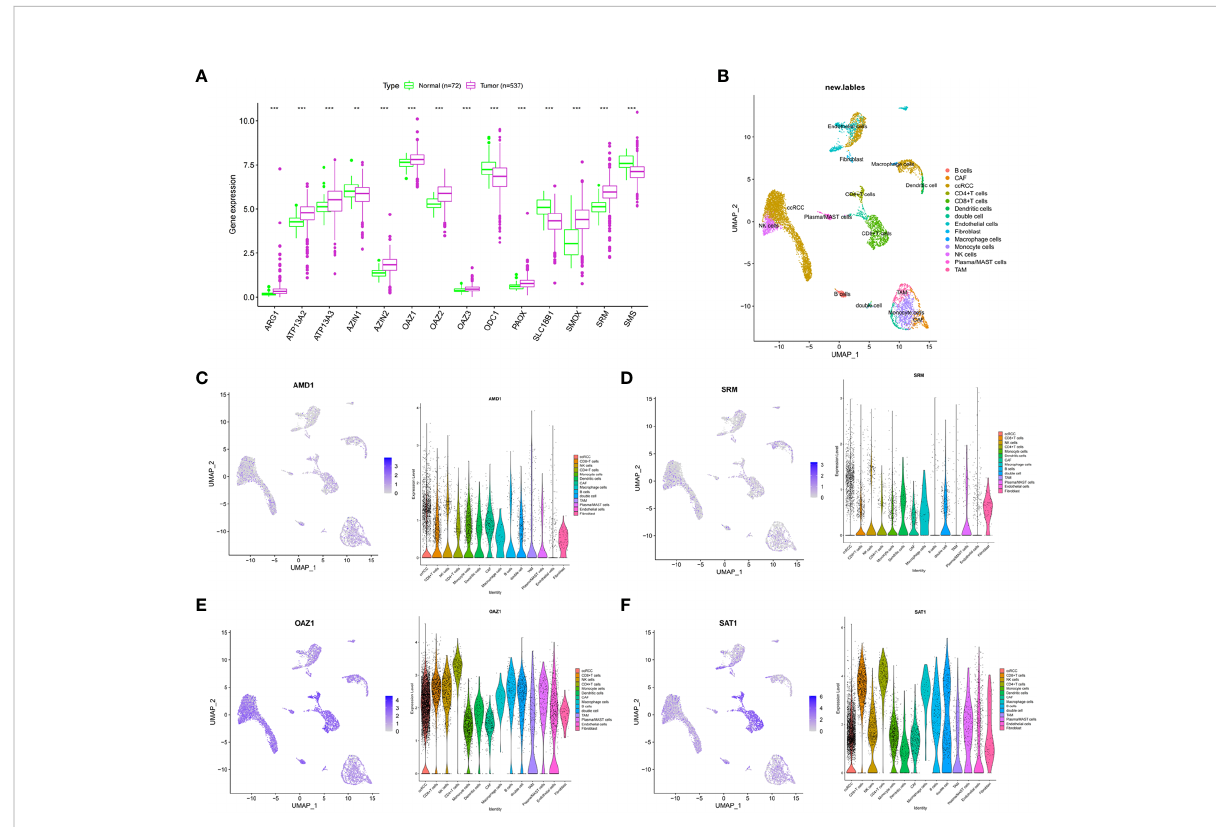
FIGURE 1 Multi-omics analysis of PMRGs in ccRCC. (A) Expression levels of PMRGs in the TCGA-ccRCC cohort. (B) UMAP plot of single cells in GSE171306 data set. (C – F) Distribution and expression patterns of AMD1, SRM, OAZ1, and SAT1 in single cells. PMRGs, polyamine metabolism- related genes; ccRCC, clear cell renal cell carcinoma. **p < 0.01, ***p <